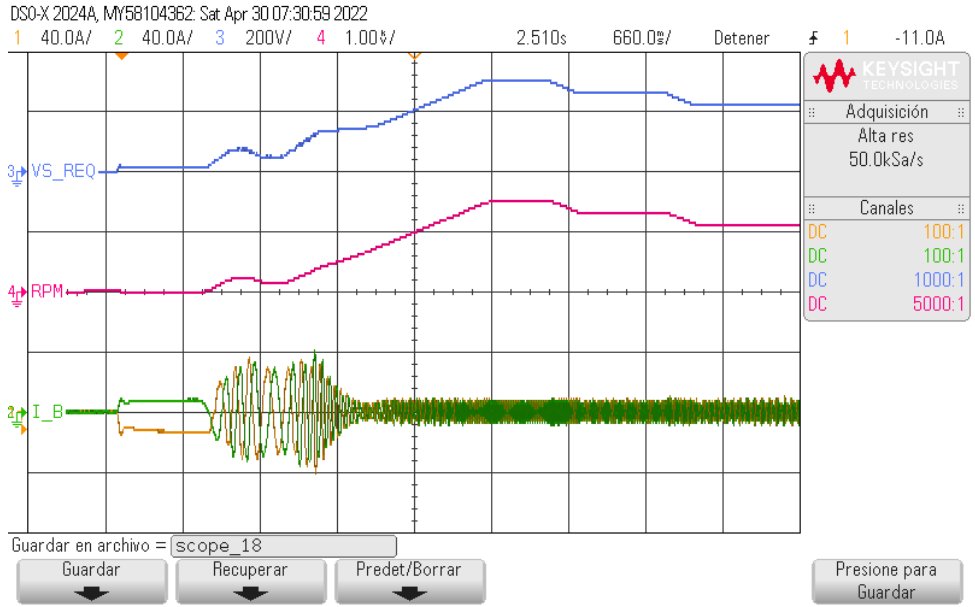
Figure 5. Oscilloscope waveforms of V ∗ s , ω r , and i a and i b , for the previous HST-SCS [17].